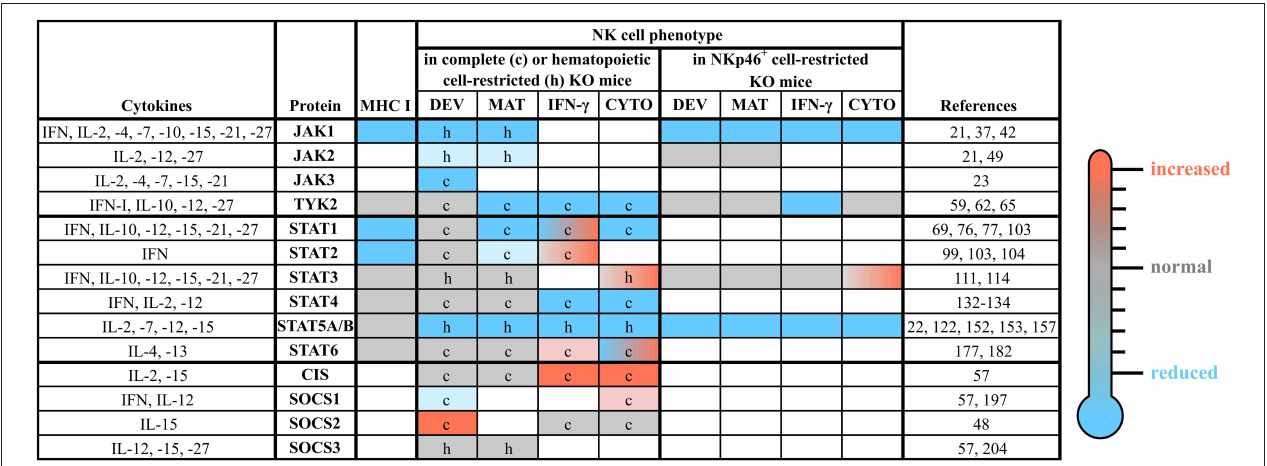
FIGURE 3 | The roles of distinct JAK/STAT and SOCS family members in NK cells. NK cell development, maturation and function are tightly regulated by a plethora of cytokines, which most prominently use the JAK/STAT pathway for their signal transduction. This figure summarizes the available literature about each member of the JAK/STAT signaling pathway and some of their negative regulators (SOCS1-3 and CIS), relevant upstream cytokines and the NK cell phenotypes observed in complete or conditional knockout mice. The individual cells are coded by color: compared to wild-type reduced (blue), unchanged (gray) or increased (red); blank cells indicate not determined yet. c, complete knockout mice; CIS, cytokine induced SH2-containing protein; CYTO, cytotoxicity; DEV, development; h, hematopoietic cell-restricted knockout mice; IFN, interferon; IL, interleukin; IFN- γ , IFN- γ production; JAK, Janus kinase; KO, knockout; MAT, maturation; MHC, major histocompatibility complex; SOCS, suppressor of cytokine signaling; STAT, signal transducer and activator of transcription; TYK2, tyrosine kinase 2.